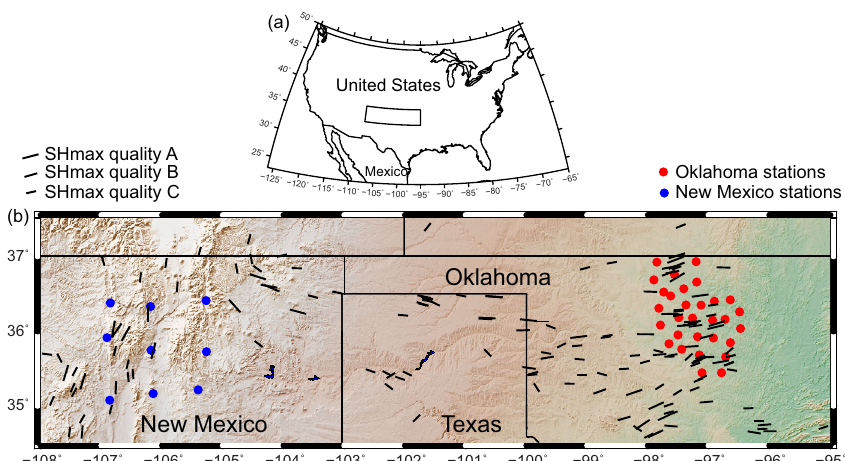
Fig. 2 Geographic location of the study area and seismic stations. The rectangle in a indicates the position of b within North America. The blue circles are seismic stations from Earthscope ’ s Transportable Array. The red circles are seismic stations from the Nanometrics Research Array. The short black lines indicate the direction of S Hmax from the 2016 release of the World Stress Map (WSM) 25 using conventional methods. Classes A, B, and C are WSM quality ratings that are identi fi ed according to length.